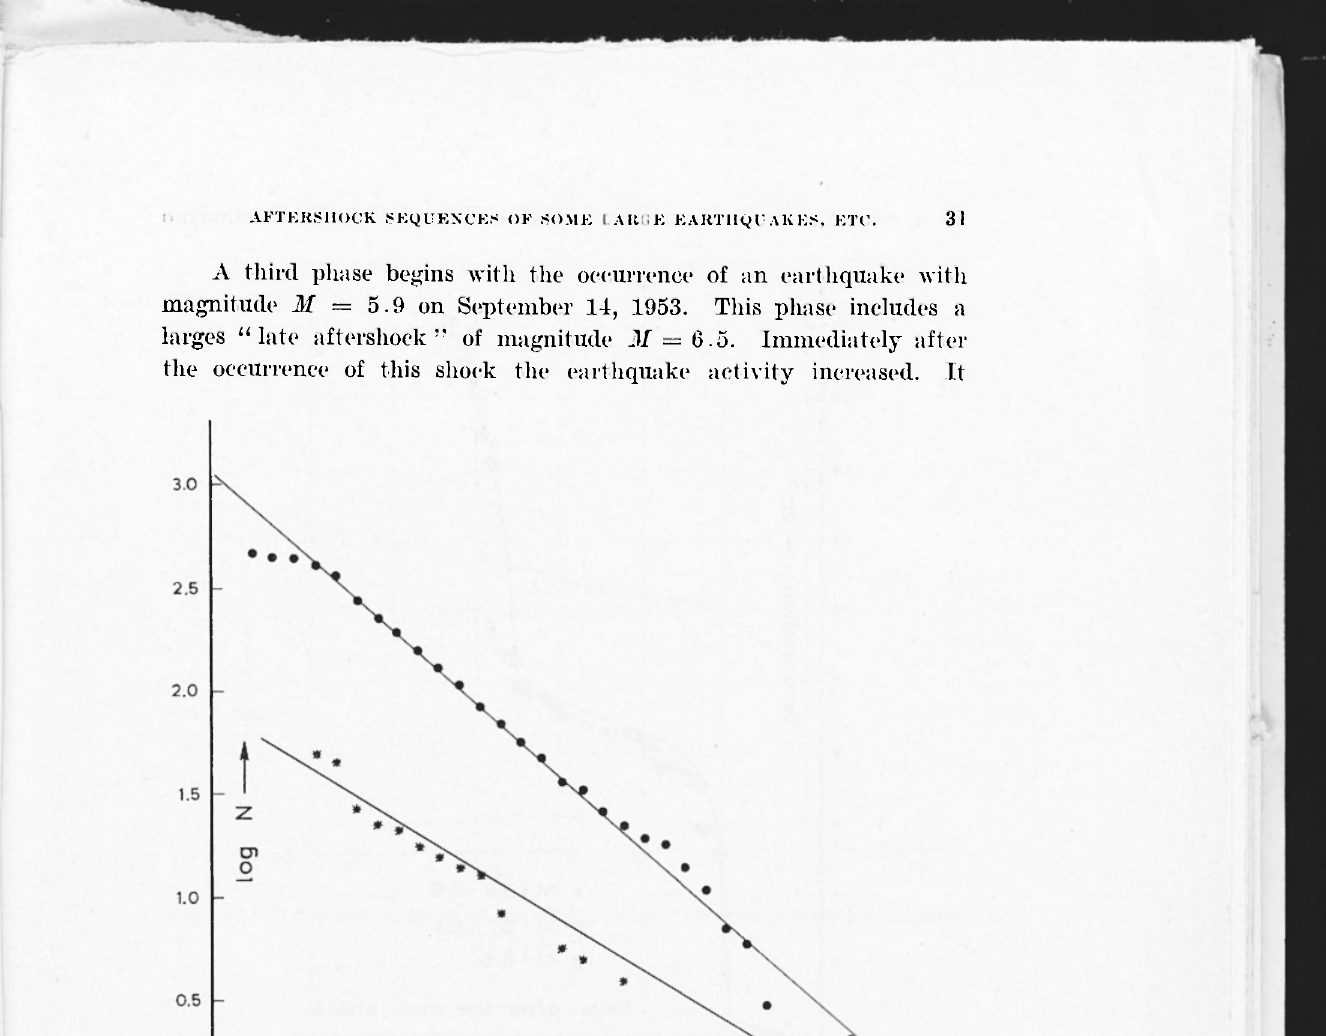
Fig. 18 - Distribution of the Magnitudes of the aftershocks and foreshocks of the Kephallenia Earthquake, of August 12,